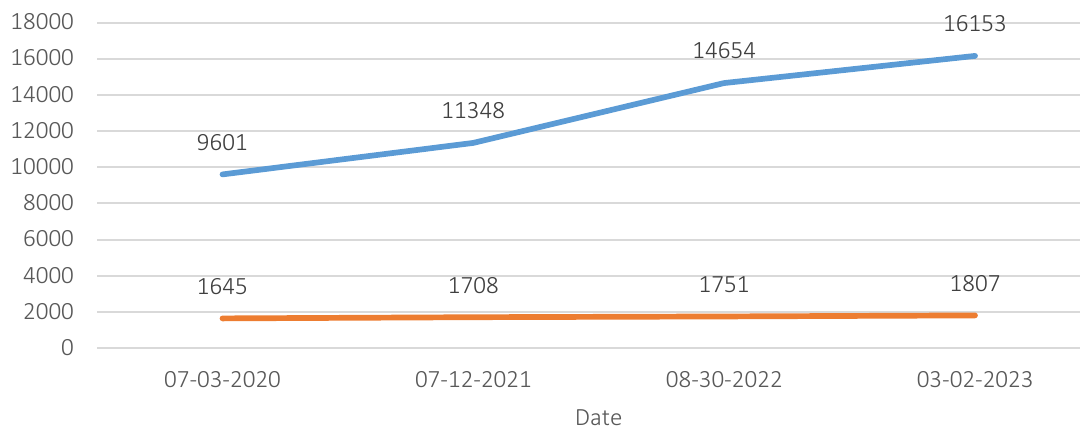
Figure 2. A contingent of education seekers and non-professionals registered in the JetIQ